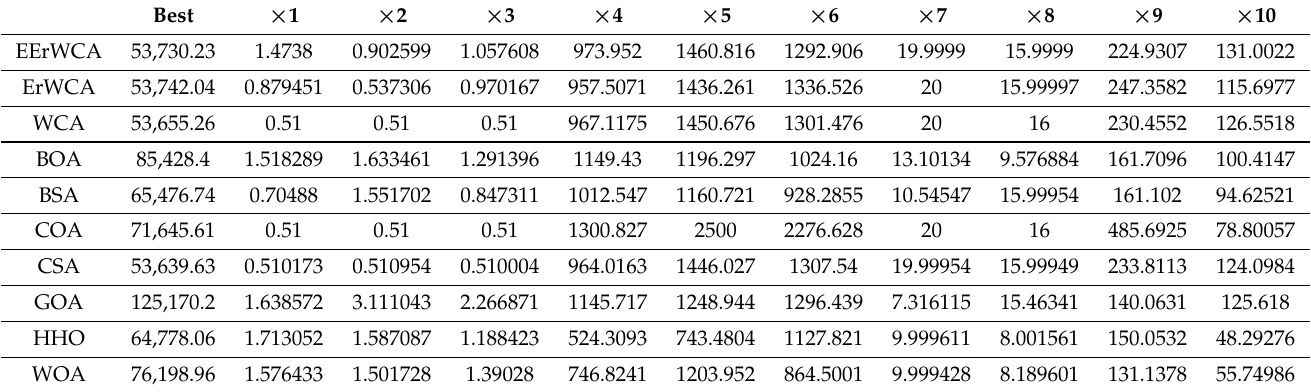
Table 10. Results of EErWCA versus other metaheuristics on multi-product batch plant.